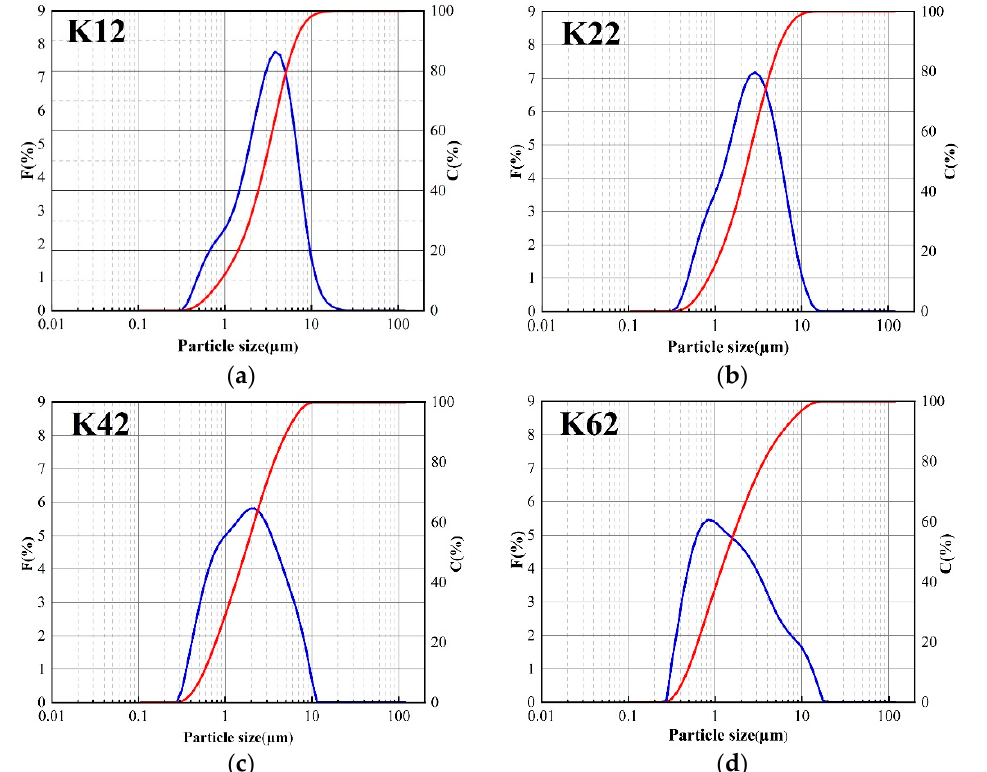
Figure 2. Particle size distribution at di ff erent ball times ( a – d ).